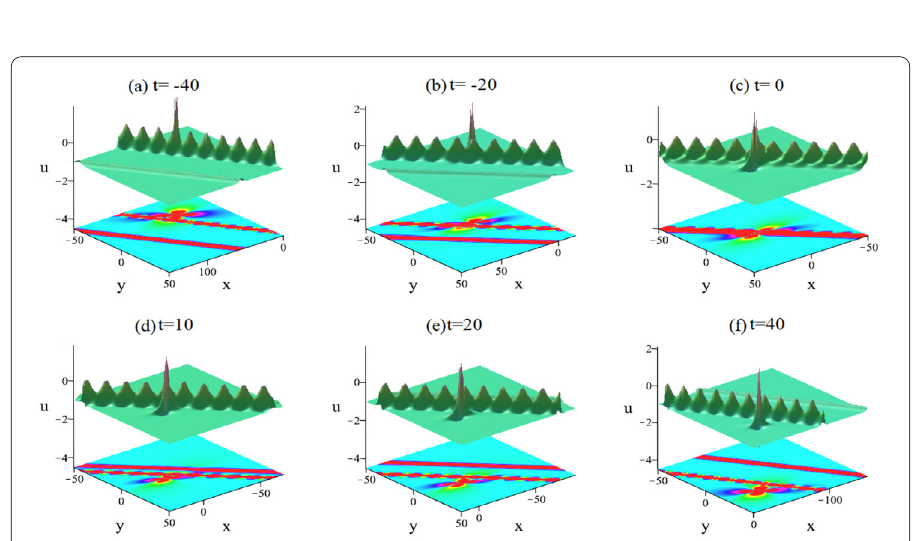
Figure 5 Surface (top) and density (bottom) plots of the mixed lump-soliton-breather interaction among one lump, one breather, and one soliton at different time and parameters in Eq.